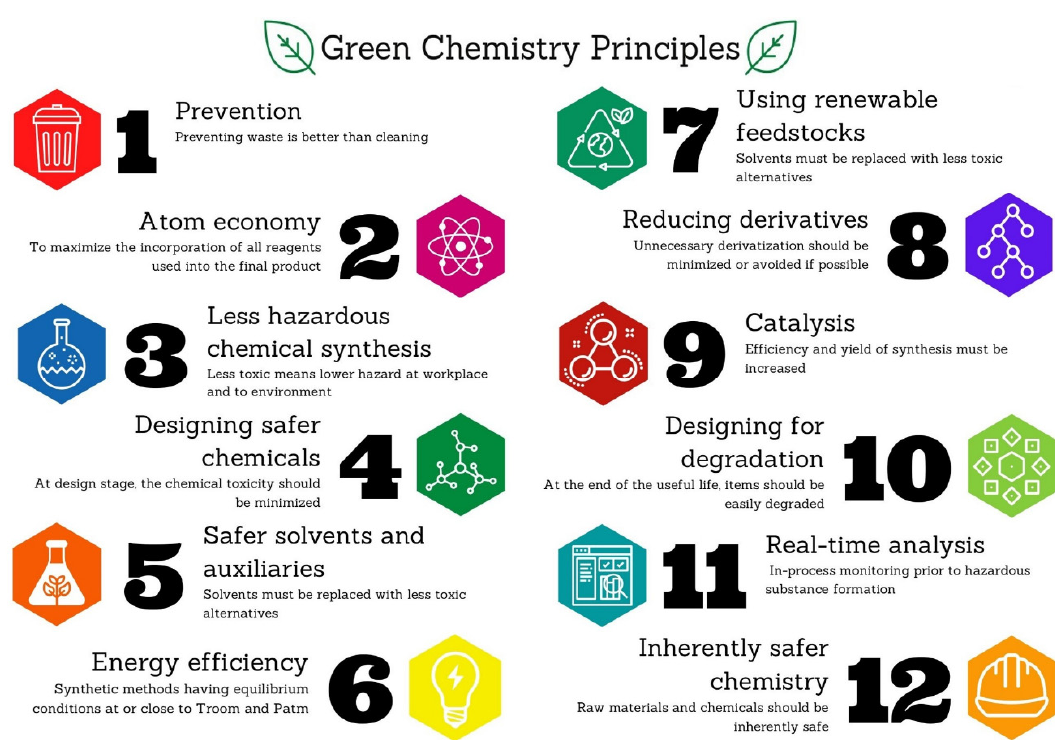
Figure 3. The Green Chemistry Principles (GCP, with information from [30]).